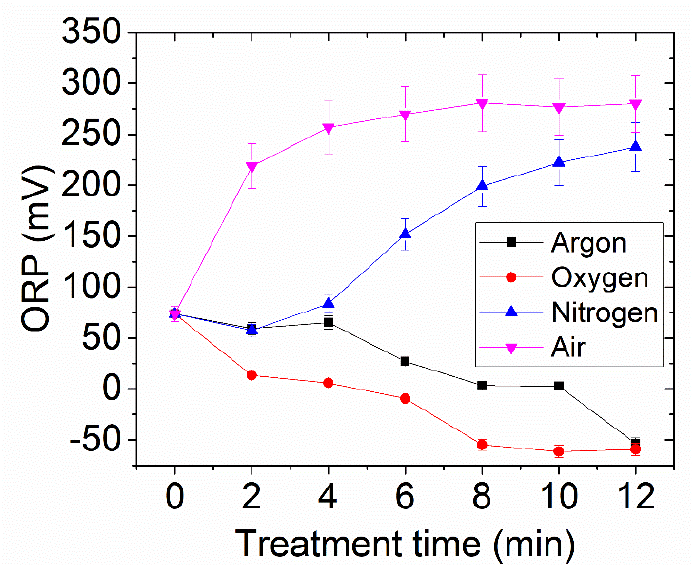
Figure 5. Variations of ORP level for plasma-activated water as a function of time with four gas feedings: argon, oxygen, nitrogen, and air.